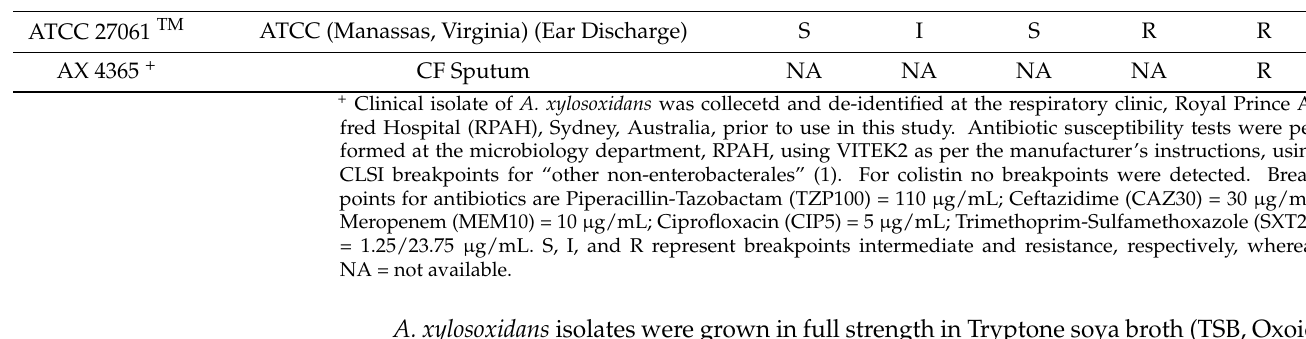
Table 1. Source and antibiotic profiles of A. xylosoxidans strains used in this study. Antibiotic Profile Strain Source TZP110 CAZ30 MEM10 CIP5 SXT25 ATCC 27061 TM ATCC (Manassas, Virginia) (Ear Discharge) S I S R R AX 4365 + CF Sputum NA NA NA NA R + Clinical isolate of A. xylosoxidans was collecetd and de-identified at the respiratory clinic, Royal Prince Al- fred Hospital (RPAH), Sydney, Australia, prior to use in this study. Antibiotic susceptibility tests were